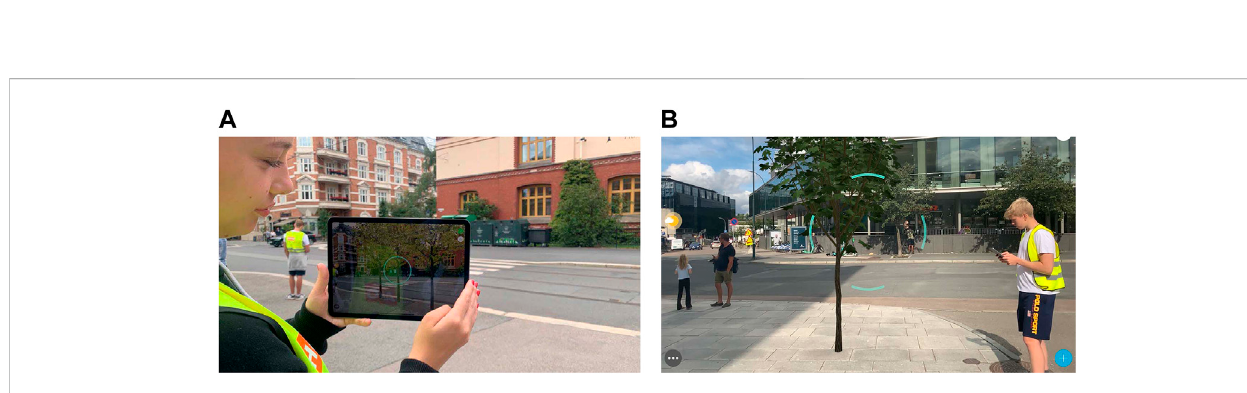
FIGURE 14 Panel (A, B) . User shows their